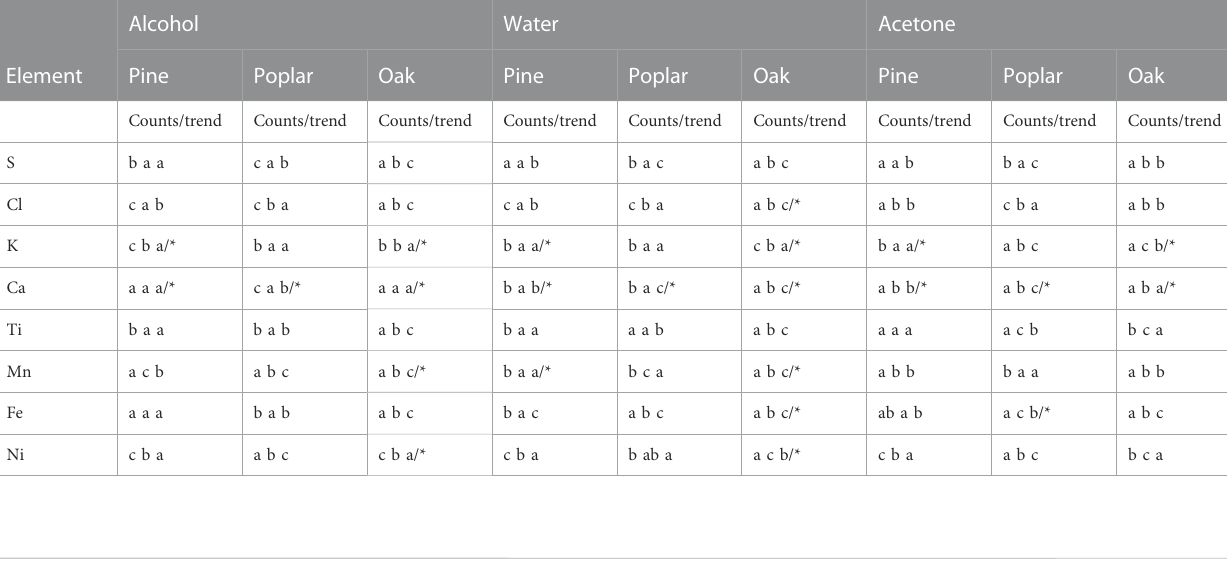
TABLE 1 Summary of observed changes in mean countrates and temporal trends of analysed elements for three different extractives. The small letters represent the results of the ANOVA-post hoc test between the three groups “ control ” , “ 12 h extraction ” and “ 24 h extraction ” (see Figure 3 for boxplots of the data).